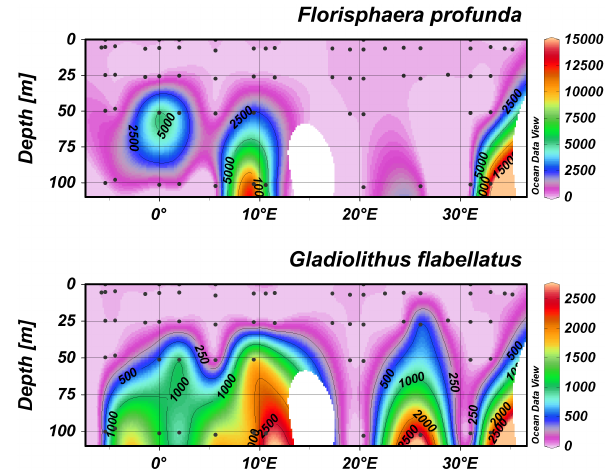
Figure 8. Distribution, along a west to east transect, of the heterococcolithophore species forming the smallest of the observed clusters comprised by 2 deep photic zone species (the transect includes the stations labeled in black in Figure 1).